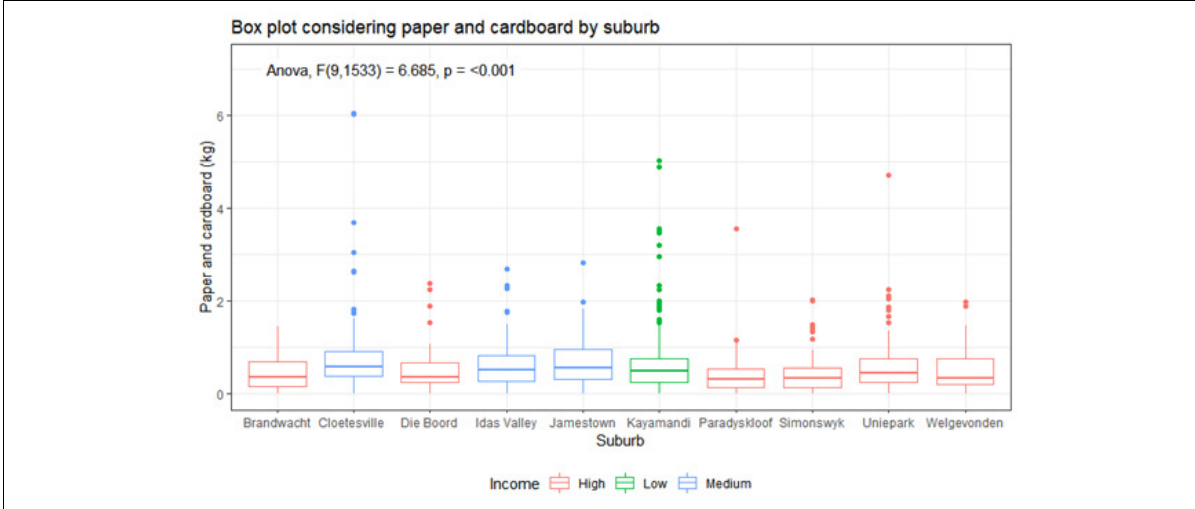
Figure 3: Box plot showing the differences in sample means for the paper and cardboard waste fraction among suburbs in Stellenbosch.